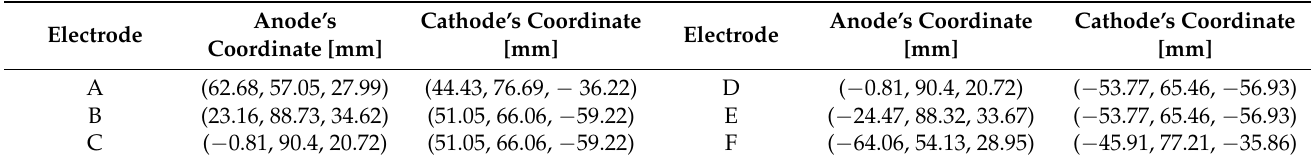
Table 4. Coordinate of each stimulus electrode used in previous study.